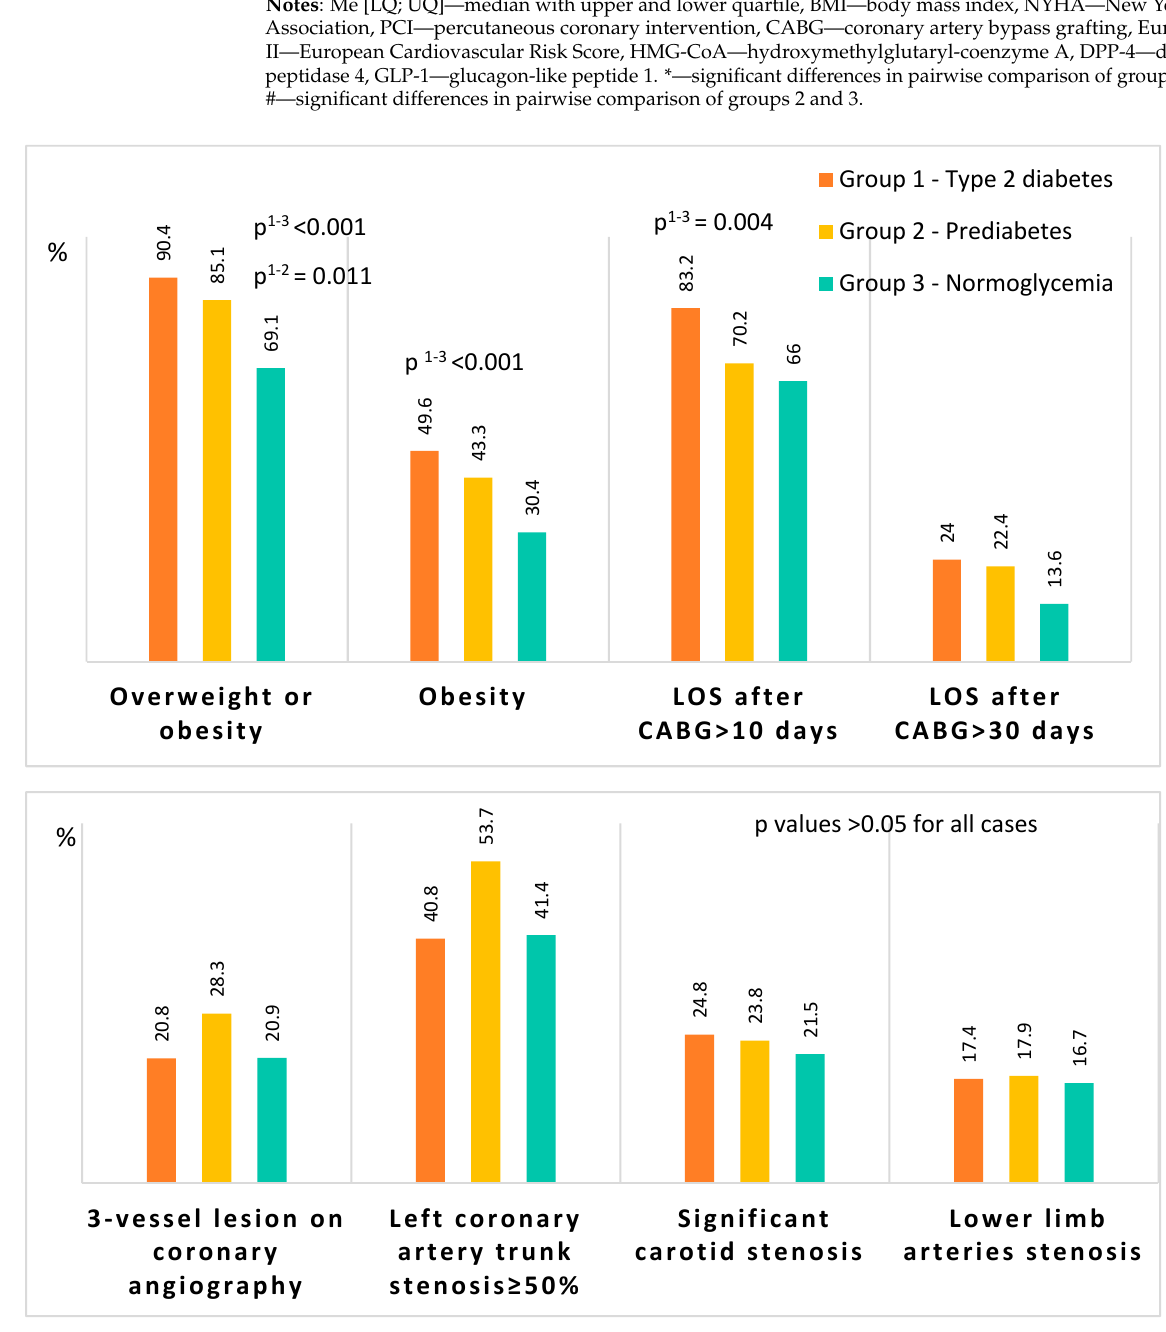
Figure 2. Overweightness, duration of hospitalization stay, and data from instrumental examinations of the coronary and non-coronary arteries. Notes: BMI—body mass index, CABG—coronary artery bypass grafting, LOS—length of hospital stay. In other cases, p values are greater than the critical significance level.